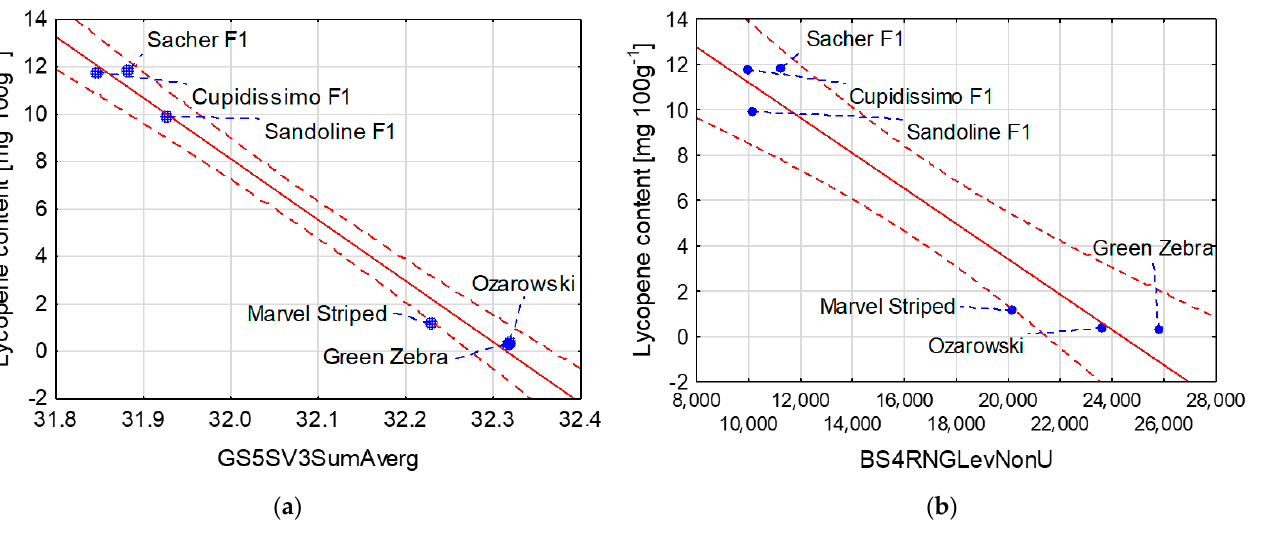
Figure 4. Scatter plots for lycopene content (mg 100 g − 1 ) and selected image textures: GS5SV3SumAverg ( a ) and BS4RNGLevNonU ( b ) from RGB color space of tomato fruit. Blue dot—mean value for the sample; blue dashed line—line connecting the mean value to the sample name; solid red line—regression line; red dashed line—confidence interval (95%). Table 3. Correlation coefficients (R) between lycopene content (mg 100 g − 1 ) and selected image tex- tures from Lab color space of ‘O˙zarowski’, ‘Marvel Striped’, ‘Green Zebra’, Sandoline F1, Cupidissimo F1, and Sacher F1 tomatoes; p <